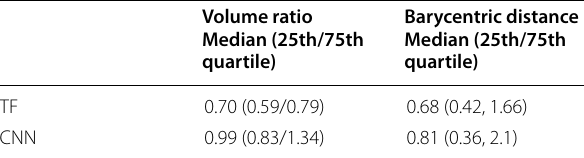
Table 1 Volume ratios and barycentric distances for TF and